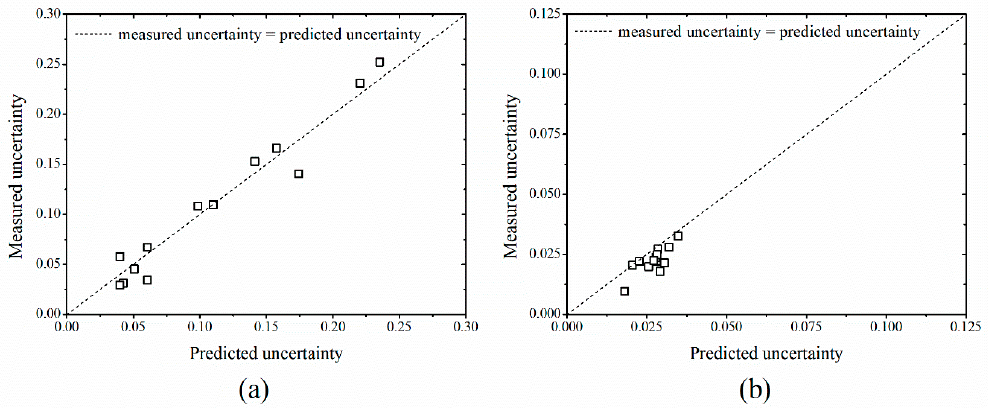
Figure 12. Comparison of the uncertainty of estimated and measured mass flow rate for ( a ) water and ( b ) sand.